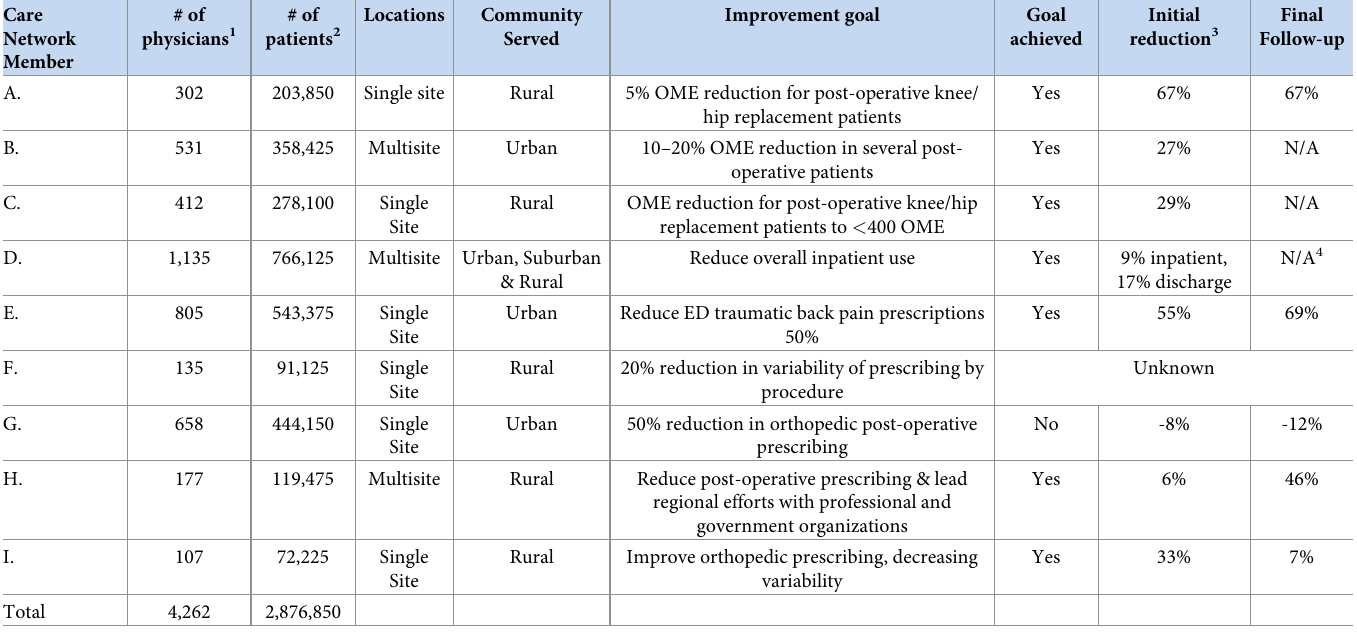
Table 1. Participating institutions. Care